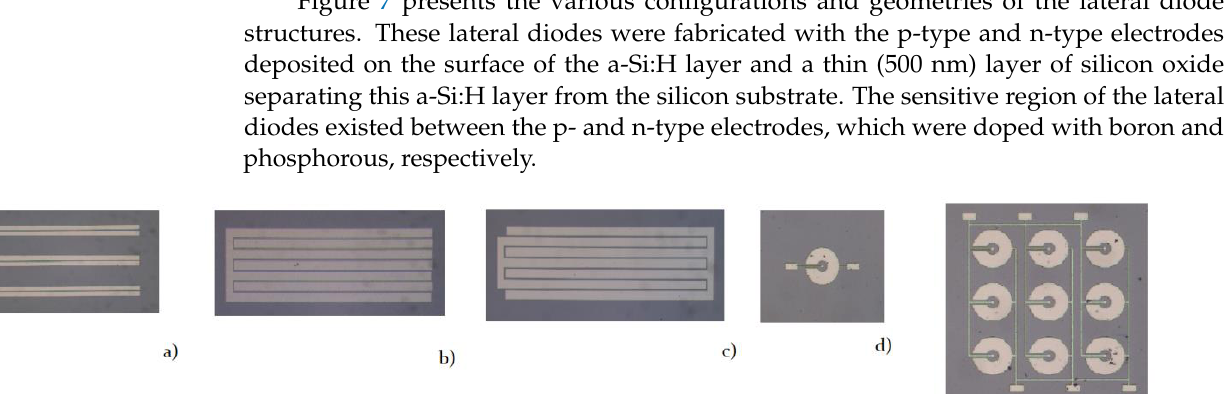
Figure 6. ( a ) I/V plot on a vertical 4 mm 2 diode where the rectifying behavior is apparent. ( b ) Reverse current versus bias voltage on two detector samples at 50 V leakage currents are 147 and 496 pA for det 1 and det 2, respectively, corresponding to current densities of 3.6 and 12.4 nA/cm 2 .